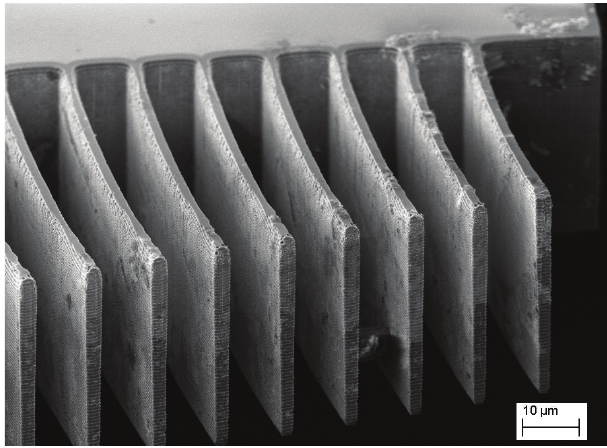
Figure 3. Comb-drive finger